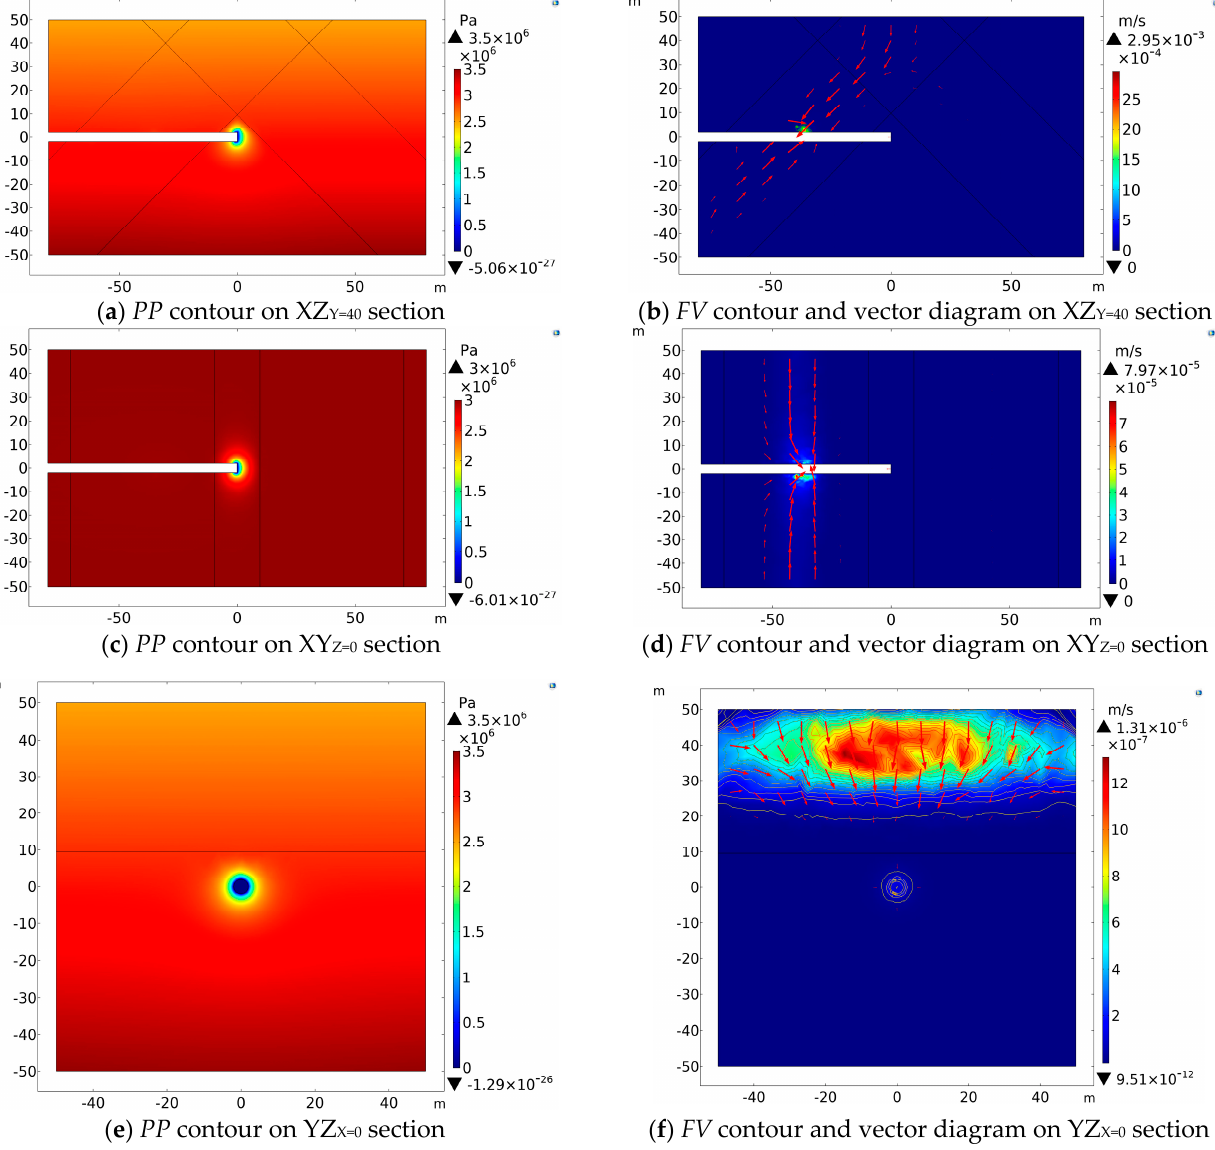
( b ) FV contour and vector diagram on XZ Y=40 section